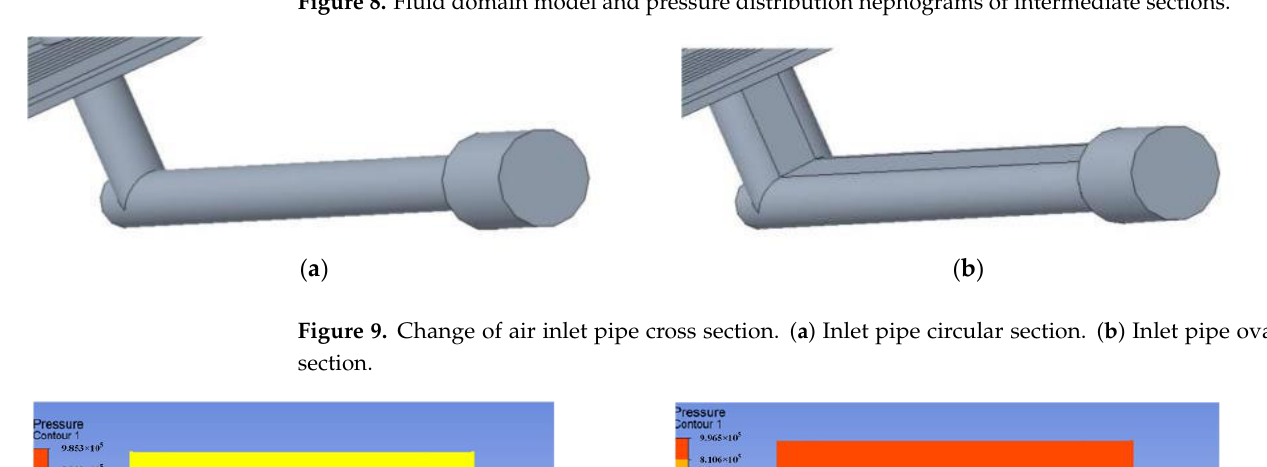
Figure 8. Fluid domain model and pressure distribution nephograms of intermediate sections.